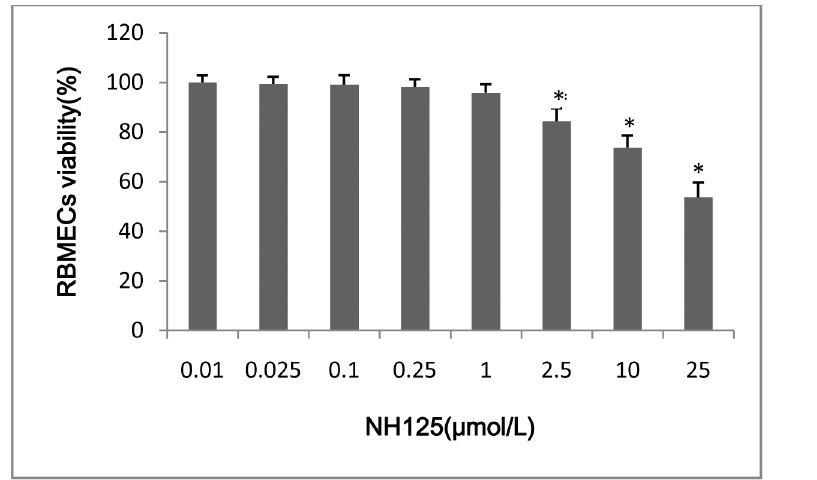
Fig 4. The effect of NH125 on the viability of RBMECs. The asterisk represents P <